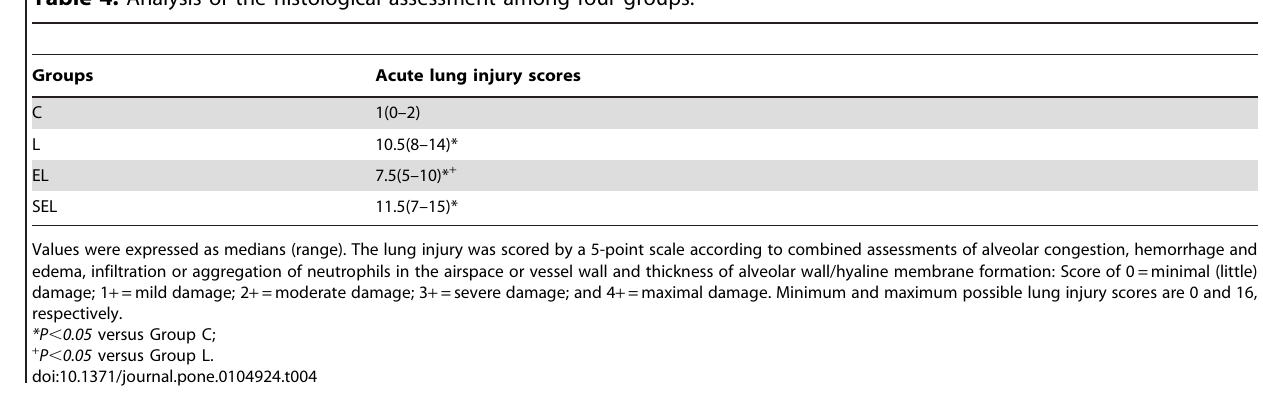
Table 4. Analysis of the histological assessment among four groups.